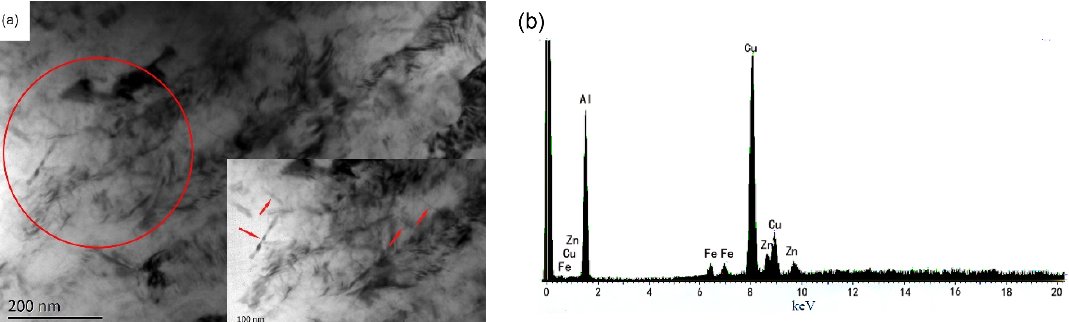
Figure 4. ( a ) TEM image and ( b ) EDS (energy dispersive spectroscopy) pattern of precipitates of SiCp/Al ‐ 5Si ‐ 1Cu ‐ 0.5Mg composite after aging treatment.